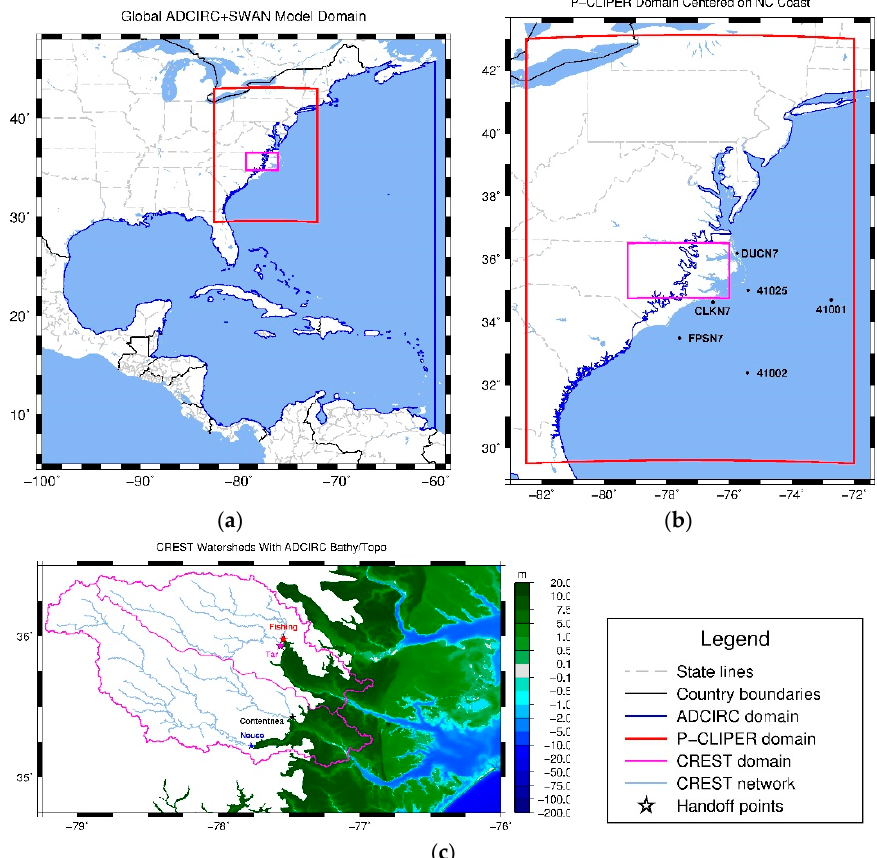
Figure 2. Study area for North Carolina coast: ( a ) Global ADCIRC + SWAN domain with inset boxes for other model regions; ( b ) P-CLIPER domain centered on North Carolina coast (location of offshore buoys used for validation in Section 3.4 shown with black dots); ( c ) Actual CREST domain; no stream network is shown below handoff points as this region is modeled by ADCIRC.